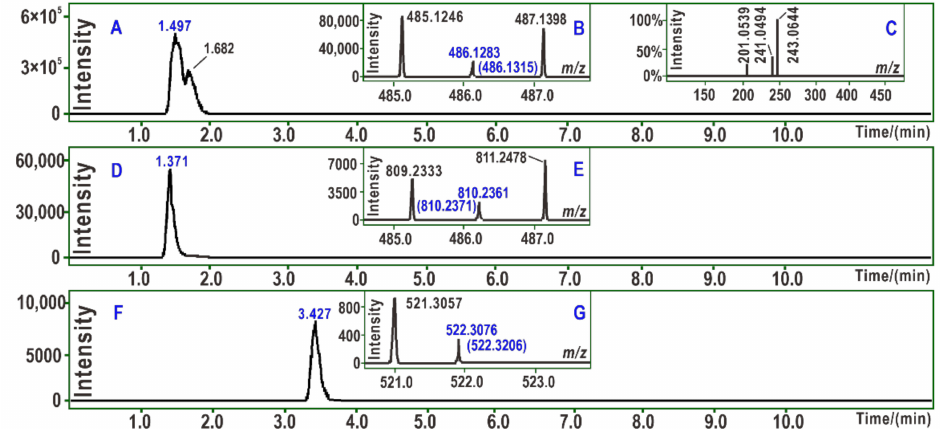
Figure 3. Main UPLC-ESI-Q-TOF-MS analysis results of ferroptosis-inhibitor and PTIO radical product mixtures. A , chromatogram of the piceatannol-piceatannol dimer product when the formula [C 28 H 22 O 8 -H] − was extracted; B , primary MS spectra of piceatannol-piceatannol dimer product; C , secondary MS spectra of piceatannol-piceatannol dimer product; D , chromatogram of the astringin- astringin dimer product when the formula [C 40 H 42 O 18 -H] - was extracted; E , primary MS spectra of astringin-astringin dimer product; F , chromatogram of the Fer-1-Fer-1 dimer product when the formula [C 30 H 42 N 4 O 4 -H] - was extracted; G, primary MS spectra of Fer-1-Fer-1 dimer product. The values in brackets are the m/z values that were calculated based on the relative atomic masses. The m/z values without brackets are the experimental values obtained in the